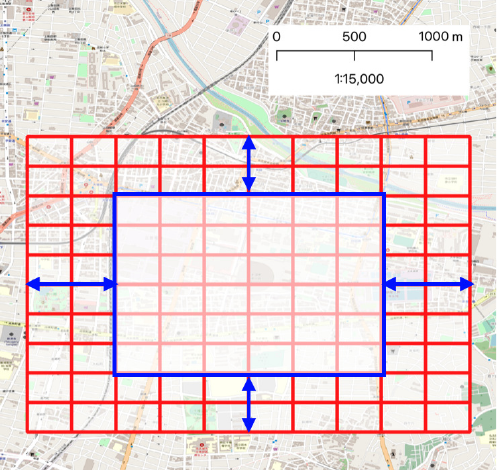
Figure 8. Analytical area.